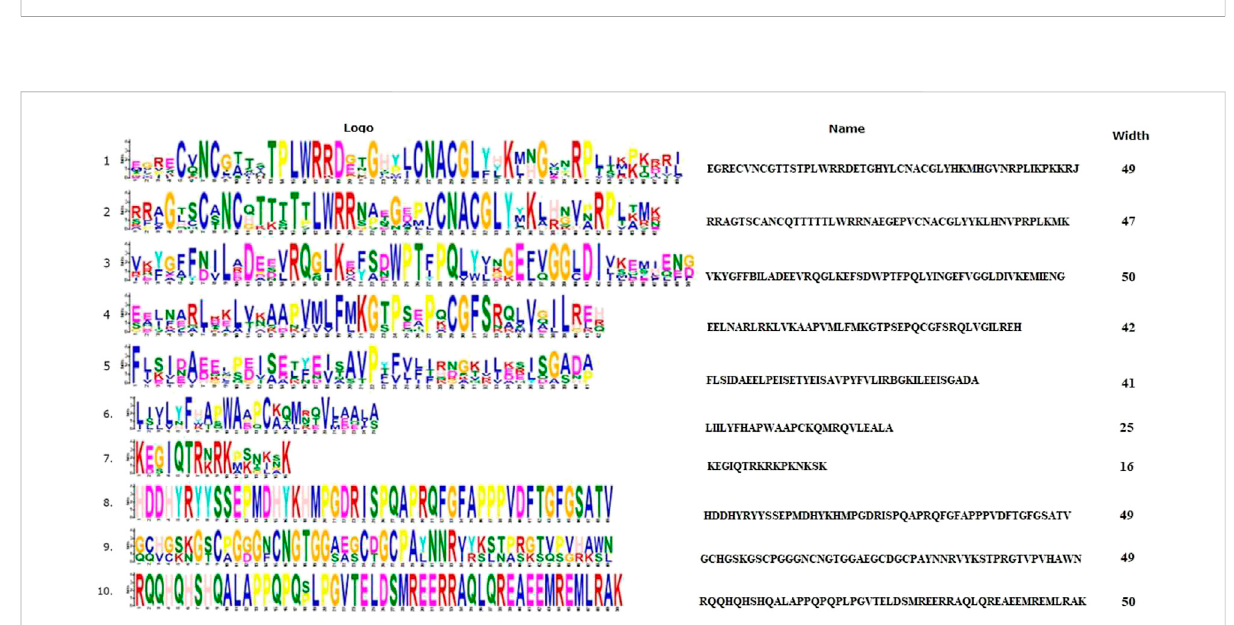
FIGURE 4 The conserved motif analysis of selected proteins in Figure 1 using the MEME Suite, where the motif composition of these proteins using 10 conserved motifs is represented by a unique color mentioned in the box on the top